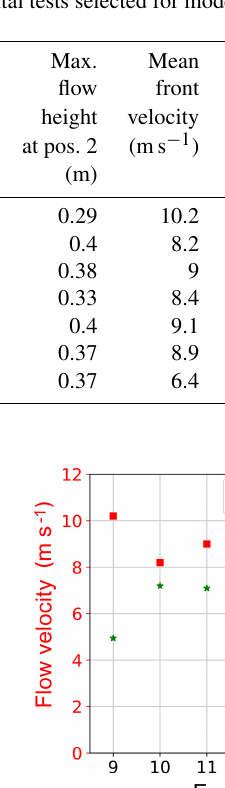
Table 1. Main flow characteristics and measured parameters for experimental tests selected for model calibration.